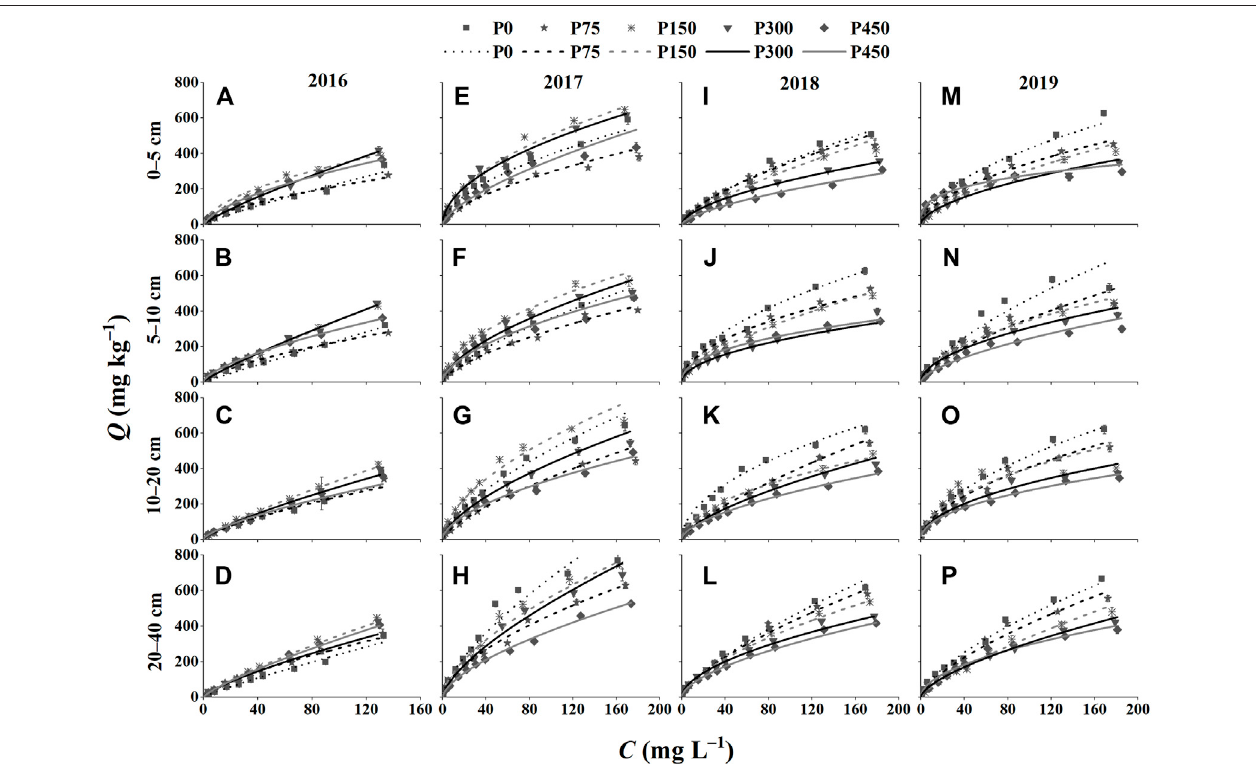
FIGURE 3 | Phosphate isothermal adsorption curves of different treatments in 2016 – 2019. (A – D) 0 – 5, 5 – 10, 10 – 20, and 20 – 40 cm in 2016; (E – H) 0 – 5, 5 – 10, 10 – 20, and 20 – 40 cm in 2017; (I – L) 0 – 5, 5 – 10, 10 – 20, and 20 – 40 cm in 2018; and (M – P) 0 – 5, 5 – 10, 10 – 20, and 20 – 40 cm in 2019. C , the P concentration in the adsorption equilibrium solution; Q , the equilibrium adsorption